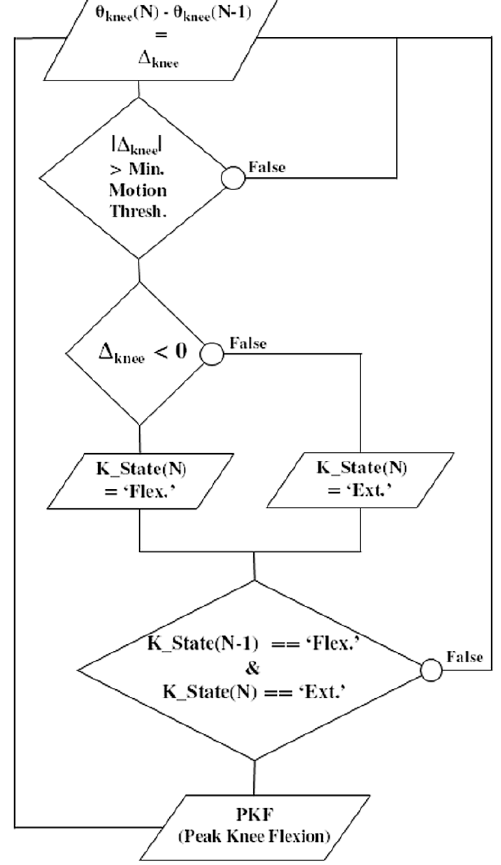
Figure 5. Flowchart illustrating the real-time detection algorithm of the ‘peak knee flexion’ (PKF) as a pre-stance stimulation event. Knee angle gradient Δ knee is computed at each new data (N). If the knee angle variation is above a minimum preset threshold, a motion is considered. The sign of Δ knee enables to know if the knee has been flexed or extended. If the previous state (K_state) was flexed and the current one is extended, a PKF flag is risen.